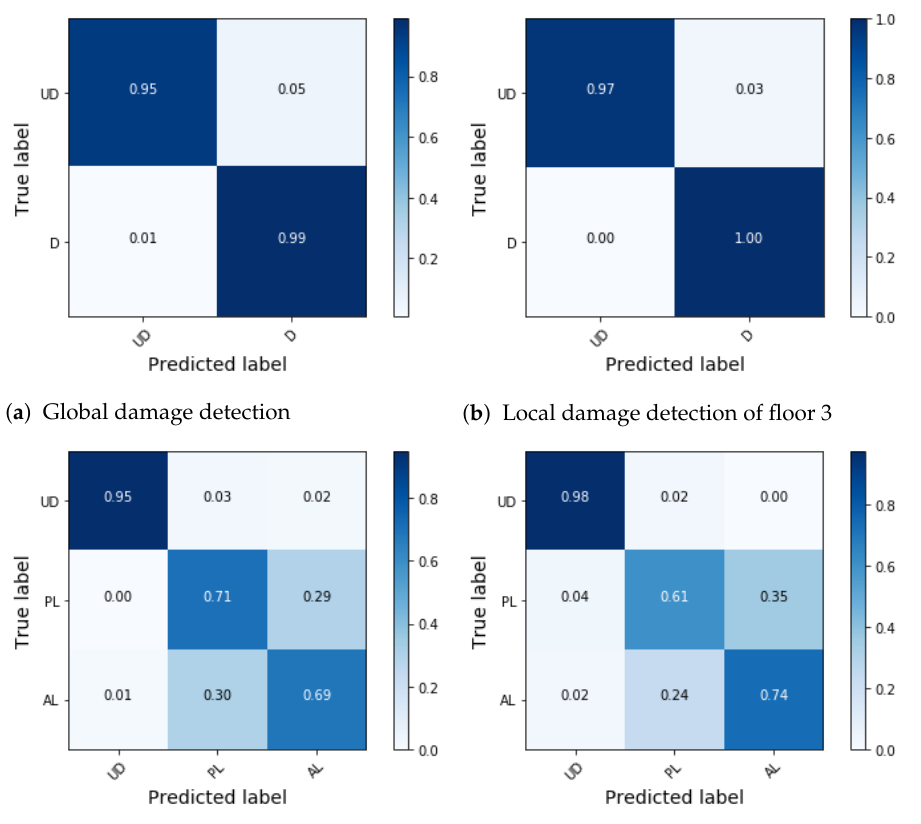
Figure 12. Confusion matrices of ARI(7,1) with